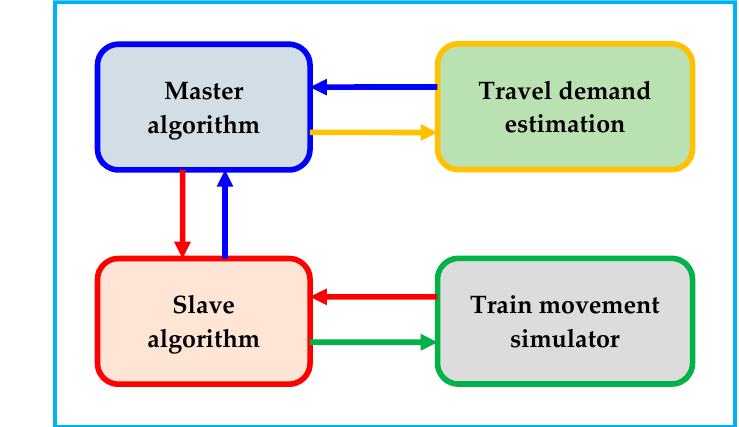
Figure 2. Approach 1 of the solution algorithm.